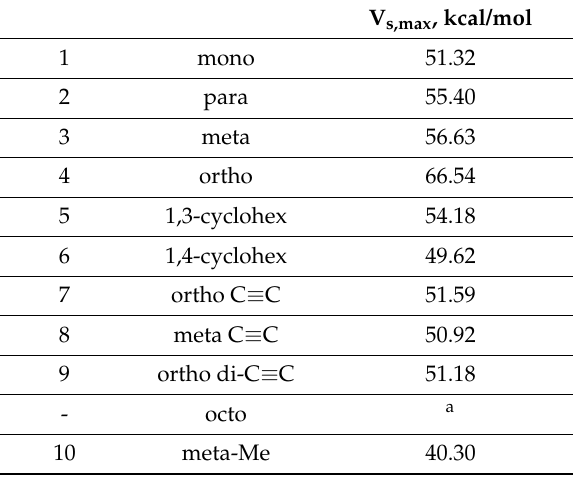
Table 8. Maximum of electrostatic potential opposite F atom of SnFH 2 group.